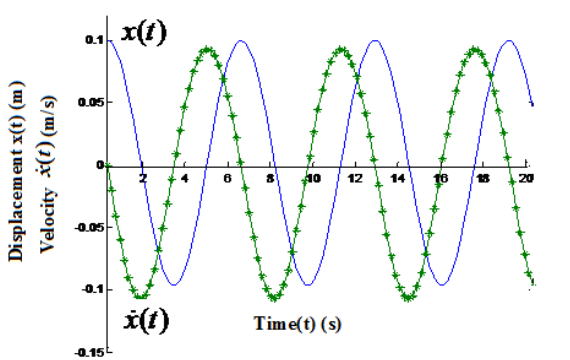
Fig. 4 Plot of displacement and velocity for oscillator Eq. (36) with weak nonlinearity and small amplitude oscillations l = 0 . 1 , α = 1 , β = 2